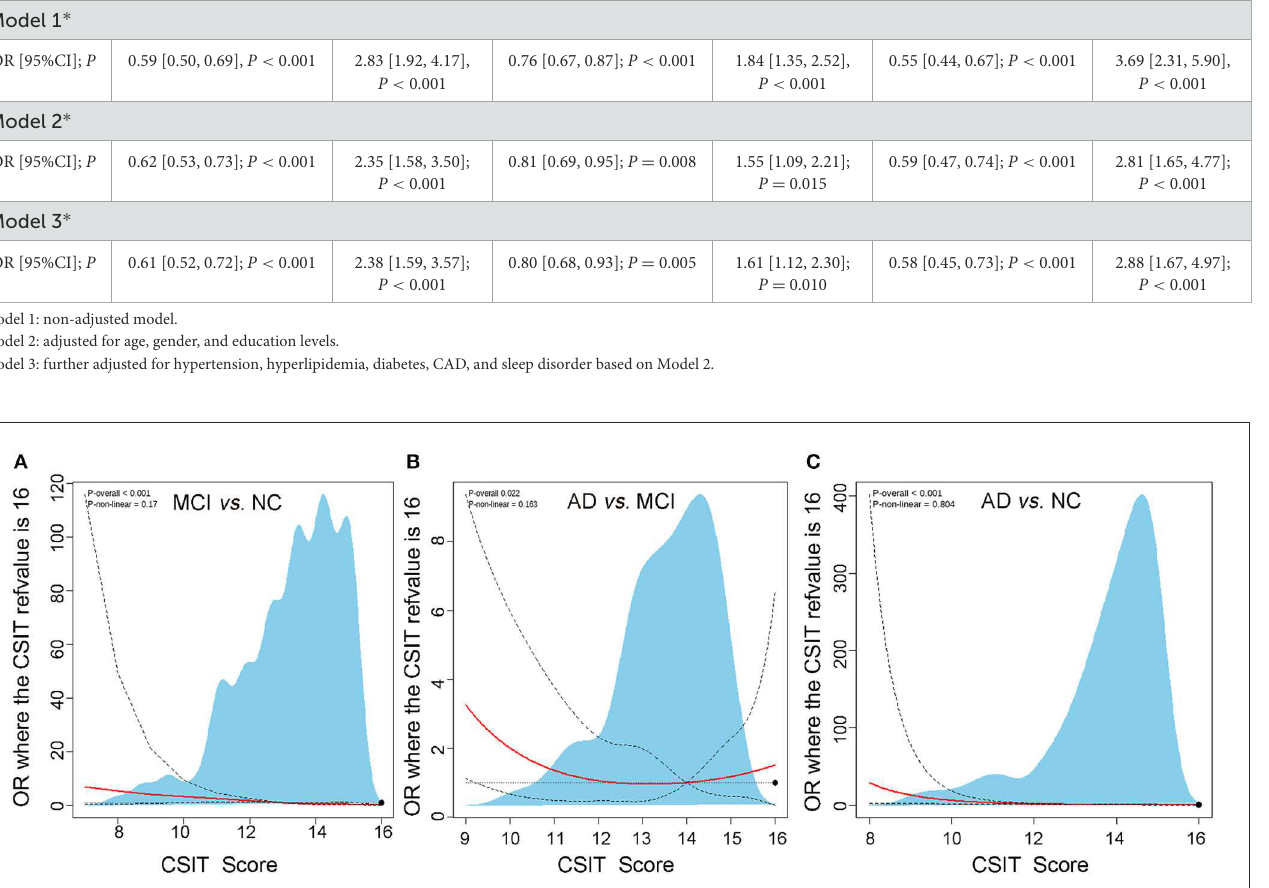
FIGURE3 The restricted cubic spline analysis of the potential non-linear association between CSTI score and risk of MCI and AD. (A) Adjusted logistic regression algorithm-based restricted cubic spline curve showing the association between CSIT and OR of MCI using three knots at specified locations according to the percentiles of the distribution of the CSTI score. (B) Restricted cubic spline plot of the association between CSIT and OR of AD differentiating from MCI using three knots. (C) Restricted cubic spline plot of the association between CSIT and OR of AD differentiating from NC using three